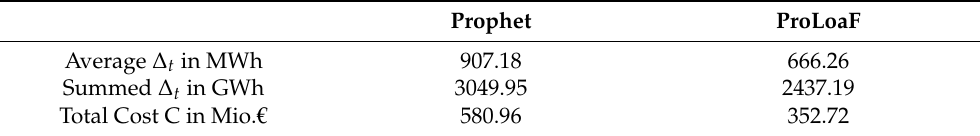
Table 7. Comparison of flat total cost for forecast errors.